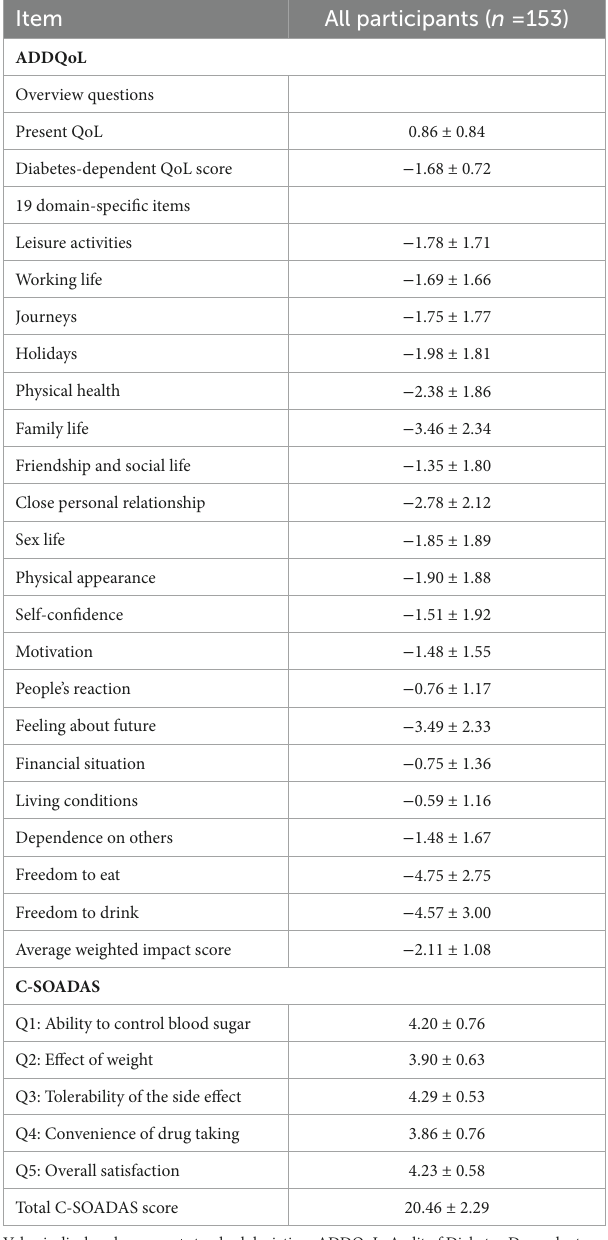
TABLE 2 ADDQoL and C-SOADAS of all